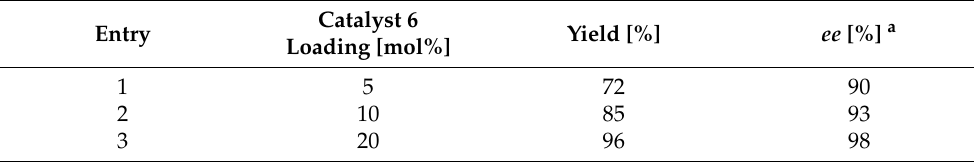
Table 2. Asymmetric MBH reaction with various catalysts 6